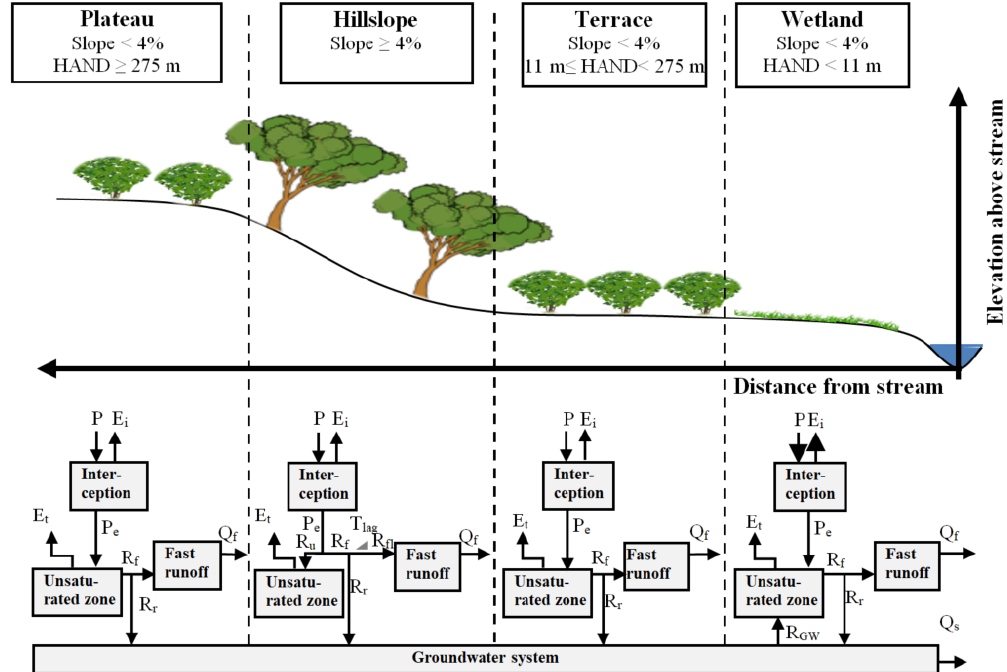
Figure 2. Sketch of the hydrological response units including the thresholds used in this analysis for the slope and HAND (height above nearest drainage) and including their corresponding model structures. This spatial sub-grid discretization was applied to each grid cell. Symbol explanation: precipitation ( P ), effective precipitation ( P e ), interception evaporation ( E i ), plant transpiration ( E t ), infiltration into the unsaturated root zone ( R u ), drainage to the fast runoff component ( R f ), delayed fast runoff ( R fl ), lag time ( T lag ), groundwater recharge ( R r ), upwelling groundwater flux ( R GW ), fast runoff ( Q f ), groundwater/slow runoff ( Q s